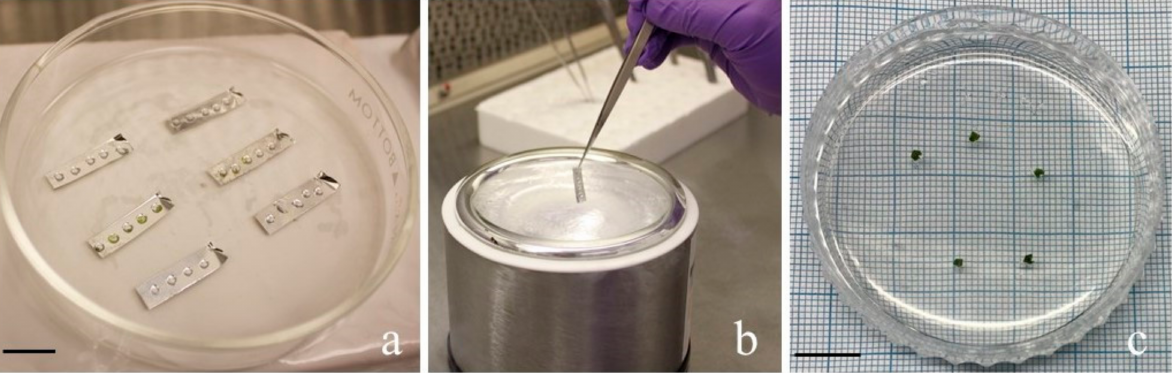
Figure 3. ( a ) the demonstration of droplet-vitrification performed in this study. ( b ) The ultra-rapid freezing performed with aluminum foil as the carrier of shoot tips. ( c ) Post-thaw cultured shoot tips after